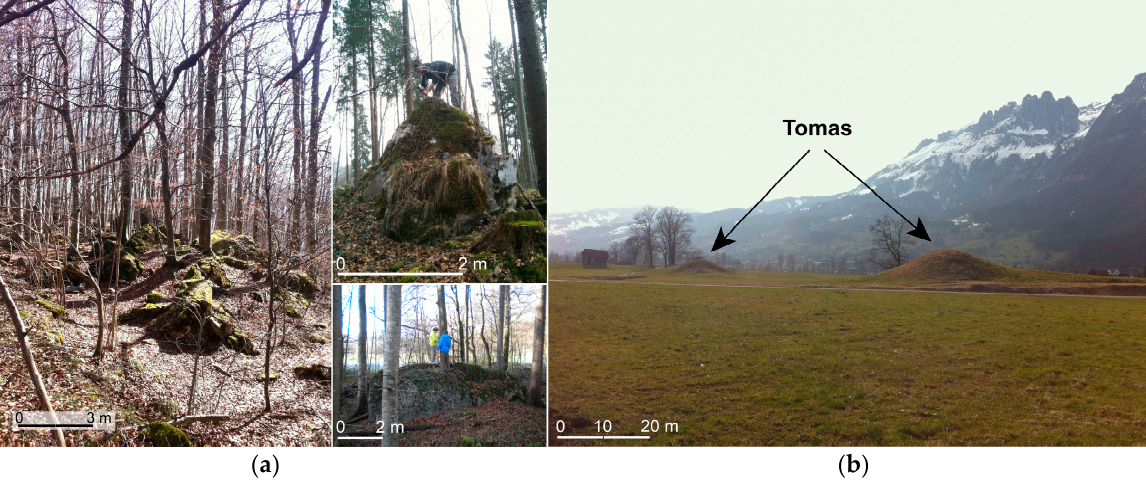
Figure 4. Field photos showing landslide boulders of various size and surface features in the landslide deposition area. ( a ) Left : 47°15 ′ 29 N–9°29 ′ 03 E, 559 m a.s.l., photo direction: 241°. Left top : Sample SW-13: 47°14 ′ 39.02 N–9°29 ′ 30.02 E, 442 m